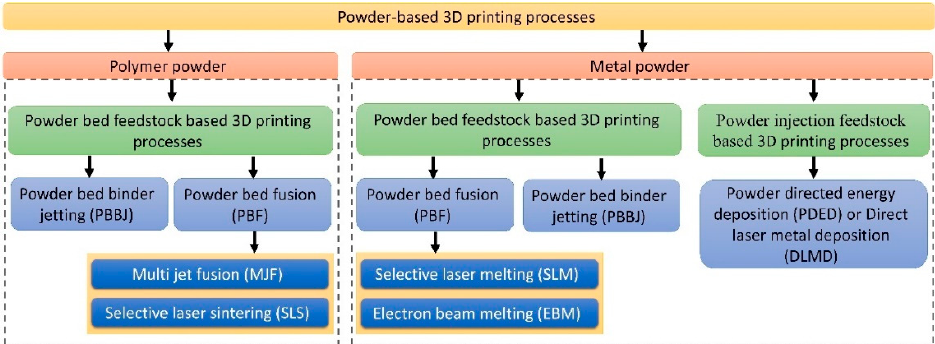
Figure 1. Classification of powder-based three-dimensional (3D) printing.